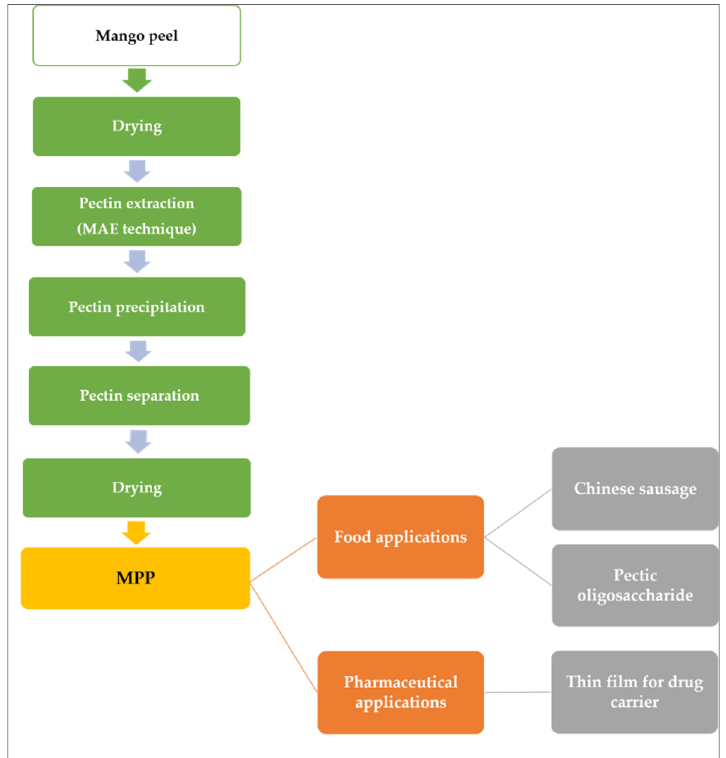
Figure 3. MPP value chain and applications.